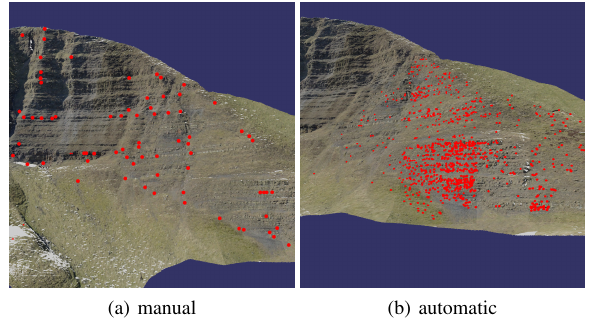
Figure 7: Comparison of manual (a) and automatic (b) control point distributions.